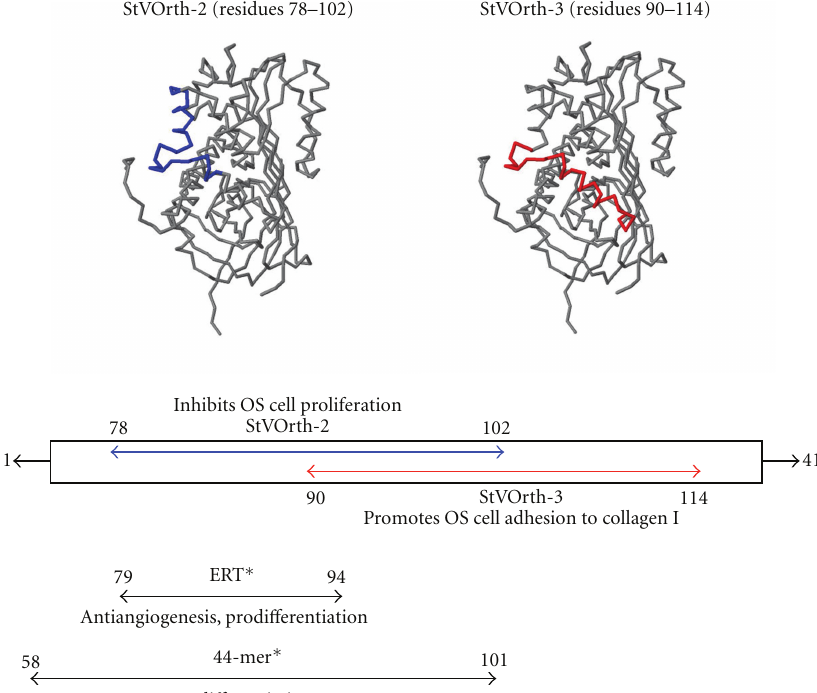
Figure 1: StVOrth-2 and StVOrth-3 peptides. StVOrth-2 (highlighted in blue) consists of residues 78–102 of the parent PEDF sequence. StVOrth-3 (highlighted in red) consists of residues 90–114. StVOrth-2 and StVOrth-3 have previously been shown to inhibit osteosarcoma cell proliferation and promote osteosarcoma cell adhesion to collagen I in vitro , respectively [7]. ∗ ERT and 44-mer peptide sequences, as described by Filleur et al. [6], overlap with the StVOrth-2 and StVOrth-3